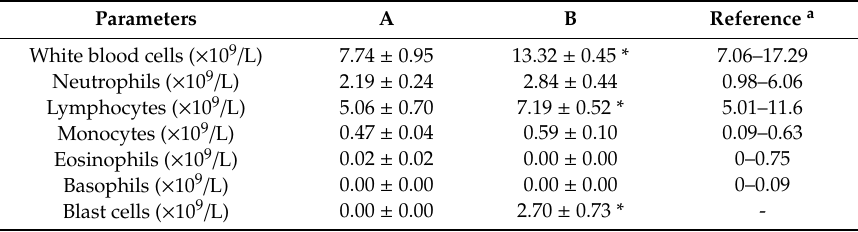
Table 3. Leukogram (mean ± SEM) of ENU-induced, leukaemic, male ICR-mice. Parameters